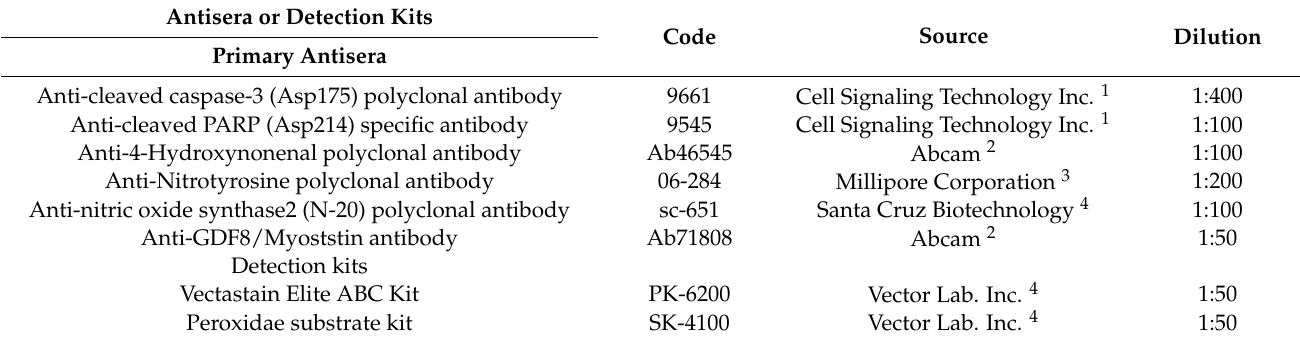
Table 2. Primary antisera and detection kits used in this